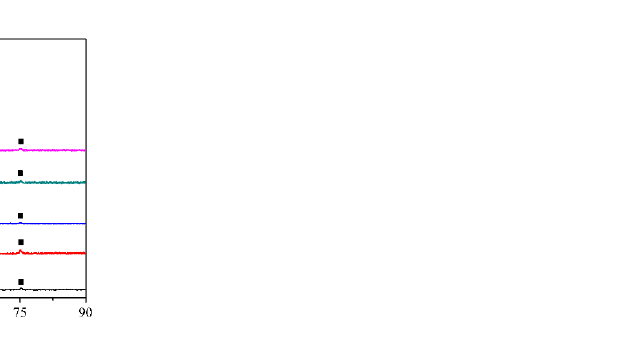
Figure 6. X-ray diffraction (XRD) patterns of the FeNiCoCr high-entropy alloys (HEAs) annealed at different temperatures. The microstructural evolution of alloys annealed at different temperatures is shown